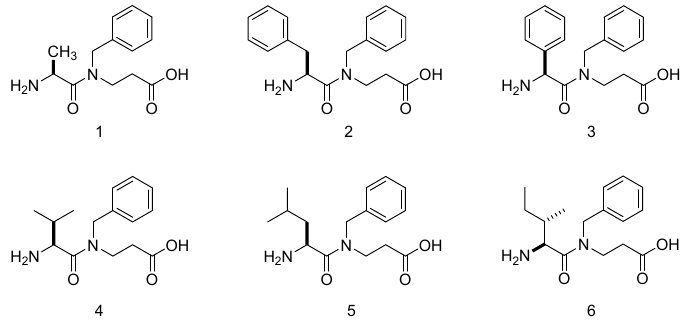
Figure 2. Dipeptides 1 – 6 examined as potential chiral organocatalysts.